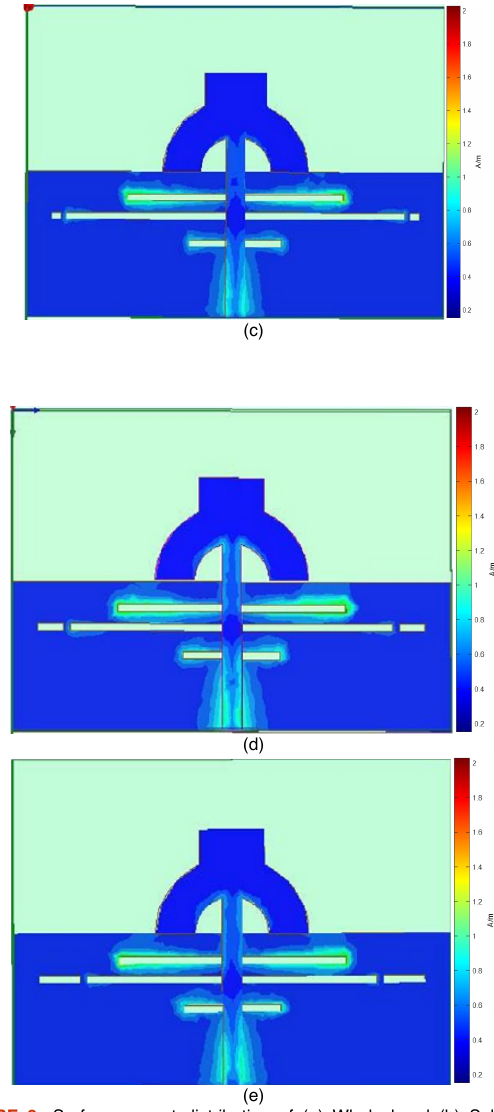
(e) FIGURE 8. Surface current distribution of (a) Whole band (b) Sub-band1 excited at 3.29GHz (c) Sub-band2 excited at 3.50GHz (d) Sub-band3 excited at 3.75GHz (e) Sub-band4 excited at 4.1GHz